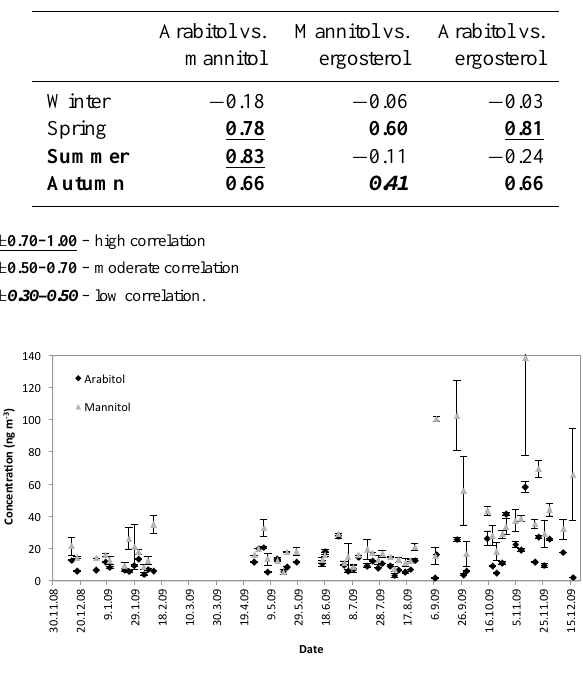
Fig. 3. Arabitol and mannitol concentrations during 2009. Missing samples are due to technical failures of the high volume sampler. High concentrations of the biomarkers are seen during the autumn.